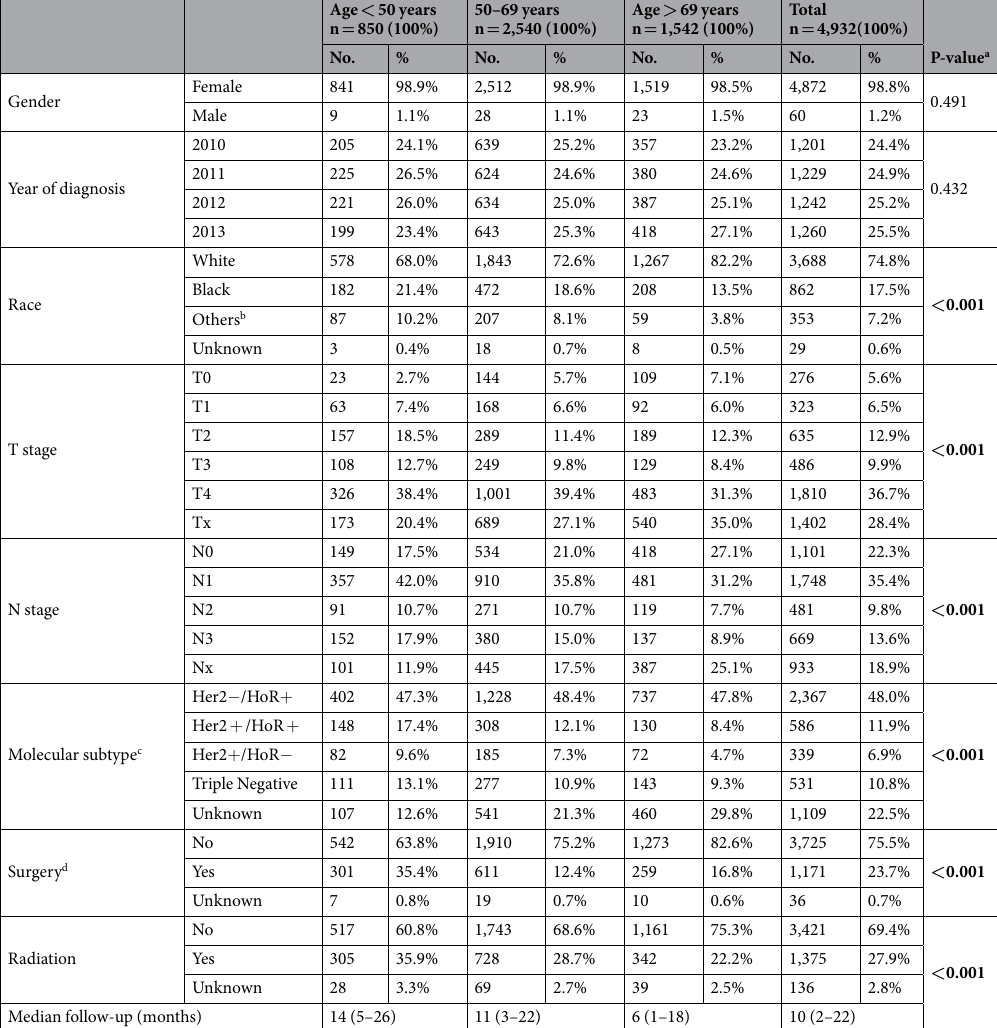
Table 1. Characteristics of breast cancer patients with distant metastasis from SEER 18 population-based registries by age groups. a The bold type indicates statistically significance. b Other races includes American Indian, AK Native, Asian and Pacific Islander. c Her2: human epidermal growth factor receptor-2; HoR: hormone receptor. d The surgery only included surgery at the primary site.